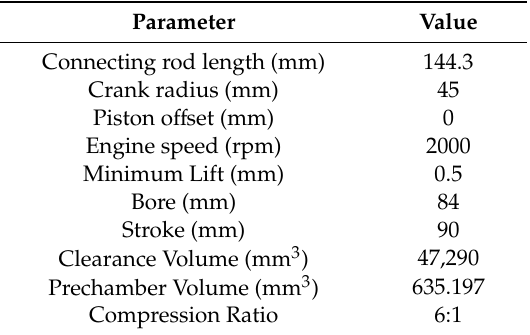
Figure 2. Configuration of the engine cylinder head with the prechamber located on the top of the pent-roof type combustion chamber (two valves each for the inlet and exhaust). The prechamber is colored as yellow. Table 1. Engine specifications.